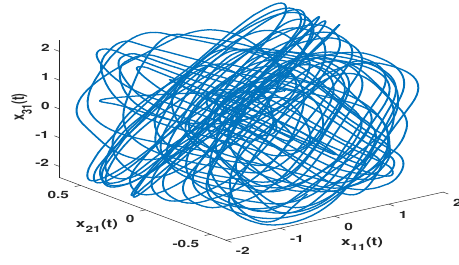
Figure 1. The chaotic trajectories of x i 1 ( t )